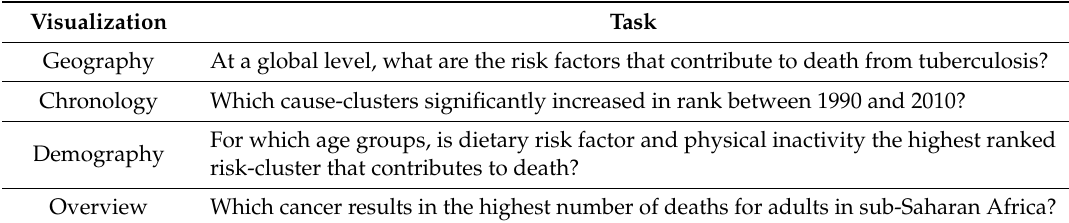
Table 4. Sample tasks for health literacy